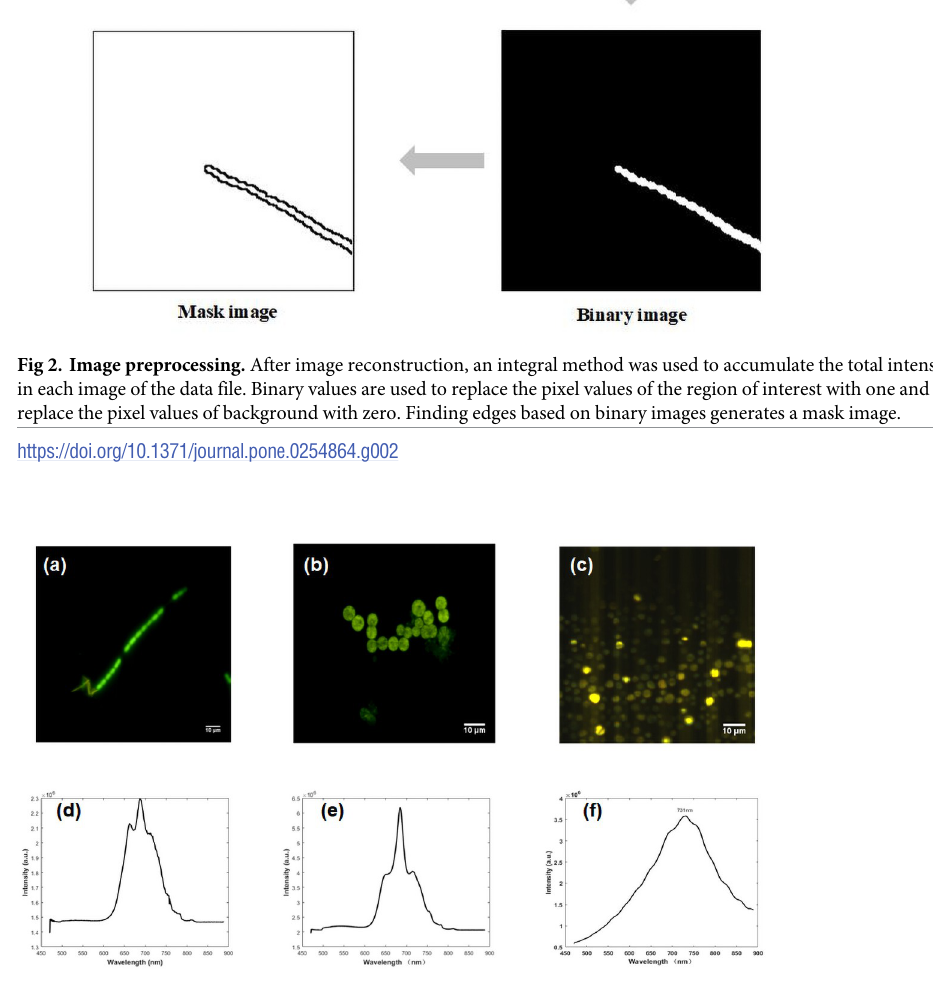
PLOS ONE | https://doi.org/10.1371/journal.pone.0254864 August 9,